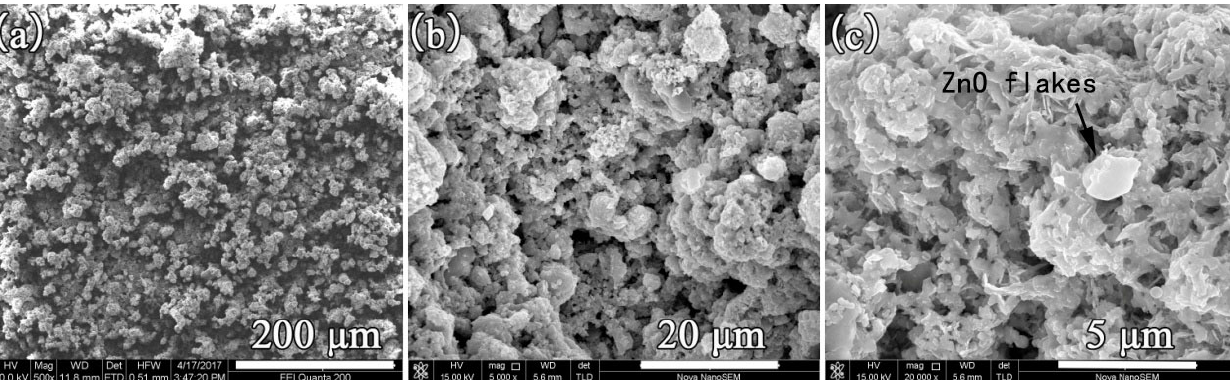
Figure 7. FE-scanning electron microscopy (SEM) image of a sample at different magnifications. ( a ): 500×; ( b ):5000× ( c ): 20,000×.